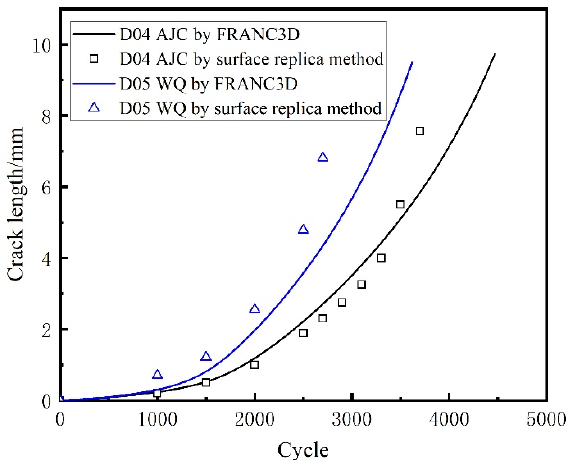
Figure 27. Comparison of crack length between the replica method and FRANC3D simulation at 45,000 rpm.